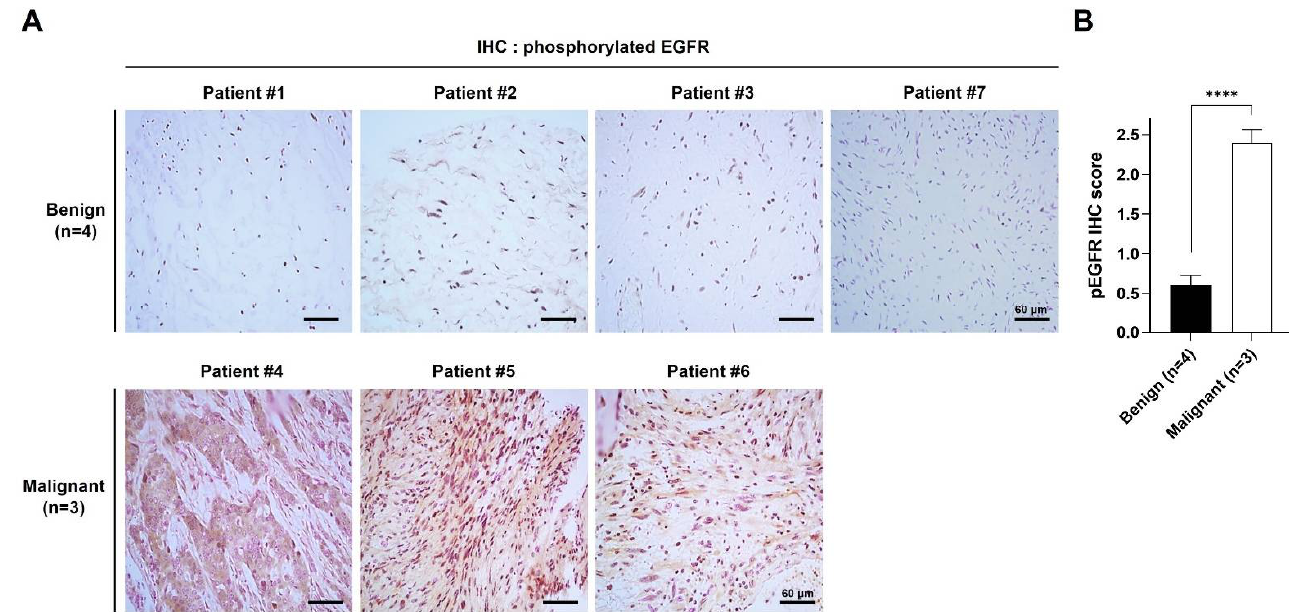
Abbreviations: NF1, neurofibromatosis type1; H&E, hematoxylin and eosin; pEGFR, phosphorylated EGFR; N/A, not an- alyzed; +, lower expression; ++, higher expression; Y, the patient had the indicated clinical features; N, the patient had not the indicated clinical features